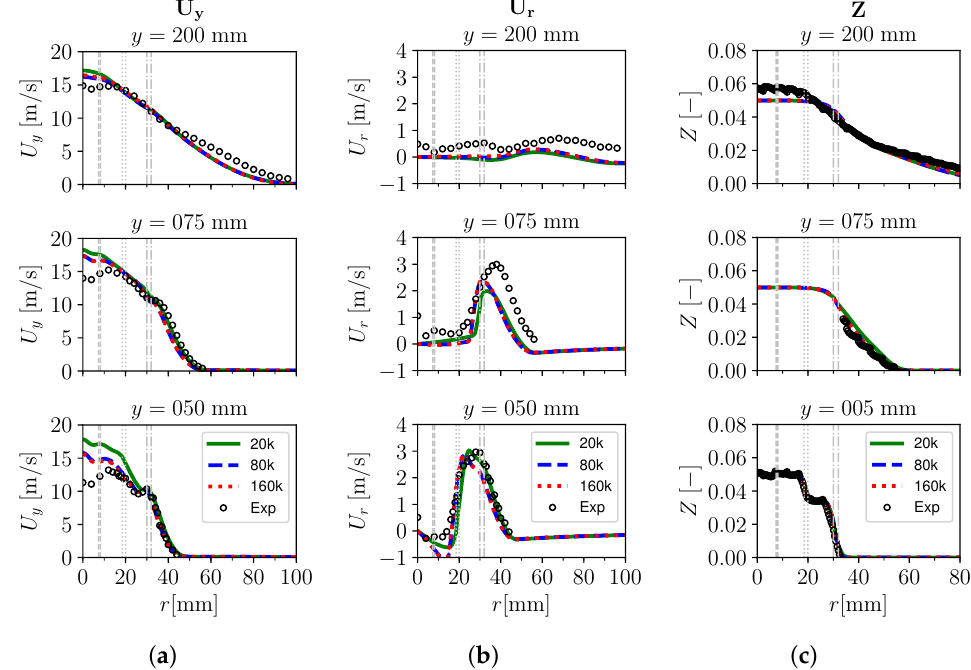
Figure A2. Case A-r: radial distributions of mean axial velocity U y ( a ), mean radial velocity U r ( b ) and mean mixture fraction Z ( c ) computed at various axial positions ( y = 50, 75 and 200 mm) with different mesh resolutions (20k, 80k and 160k cells) in comparison with experimental